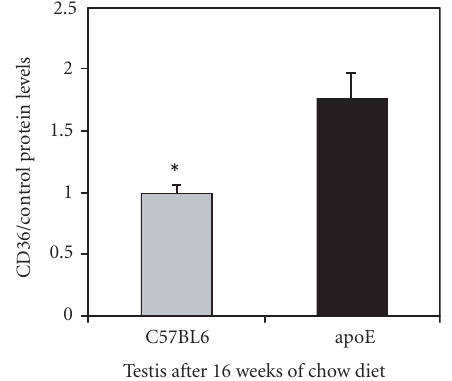
Figure 5. Western blot analysis of CD36 protein levels in the testis.